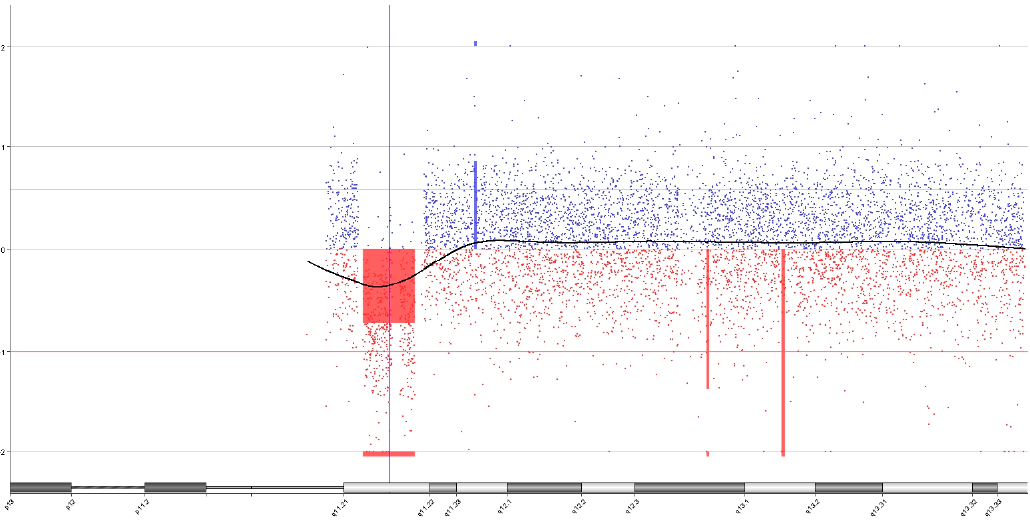
Figure 4. Chromosomal microarray analysis showing 2.5 Mb deletions of 22q11.21 in a three-month- old patient [BL-363-12] with DD, congenital heart disease, and DiGeorge